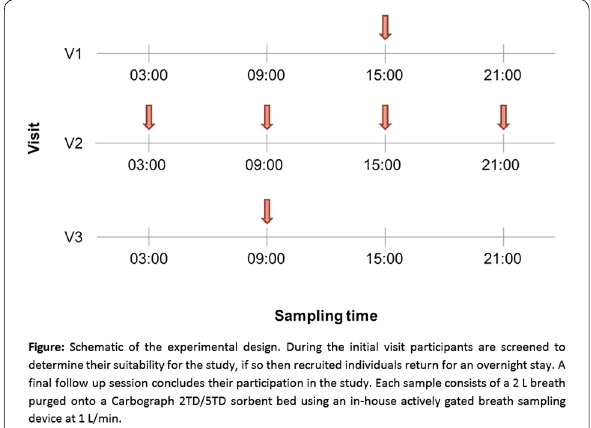
Figure 4 Schematic of the experimental